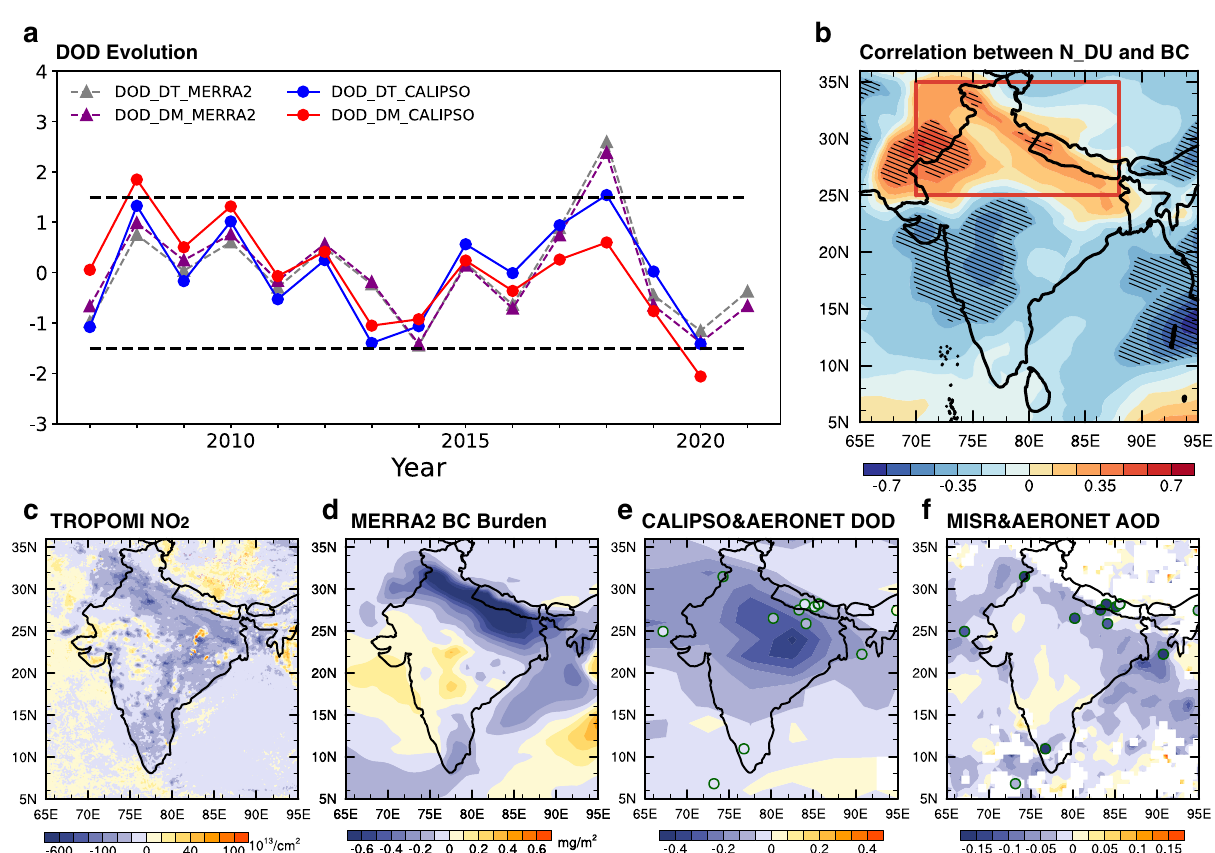
Fig. 1 BC, DU, AOD, and NO 2 for the premonsoon season. a Time series of normalized anomalies of dust optical depth (DOD) after removing the long- term trend (DOD_DT, blue) and after subtracting the long-term mean (DOD_DM, red) over India from CALIPSO (2007 – 2020) (solid lines) as well as the counterparts (DOD_DT in gray and DOD_DM in purple) from MERRA-2 (2007 – 2021) (dashed lines). b Correlation coef fi cients between northern Indian DU (averaged over the square) and BC over each grid cell of the Indian subcontinent from MERRA-2 in April-May. Areas exceeding the 90% con fi dence level are hatched using Student ’ s t -test. c – f Spatial distributions of differences of c NO 2 concentrations from TROPOMI, d BC burdens in MERRA-2, e AOD of dust in CALIPSO (contour fi ll) and of coarse-mode in AERONET (colored circles), and f aerosol optical depth (AOD at 550 nm) from MISR (contour fi ll) and AERONET (colored circles) between 2020 and 2015 –